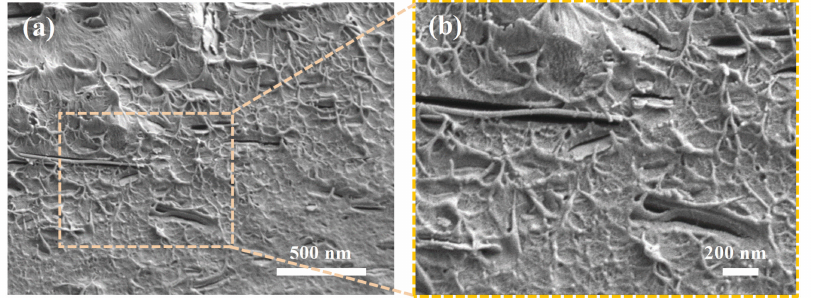
Figure 2. ( a ) The cross-section SEM images of the composites filled with 1 wt% BN@PDA and 0.5 wt% STNSs. ( b ) The enlarged area of ( a ).